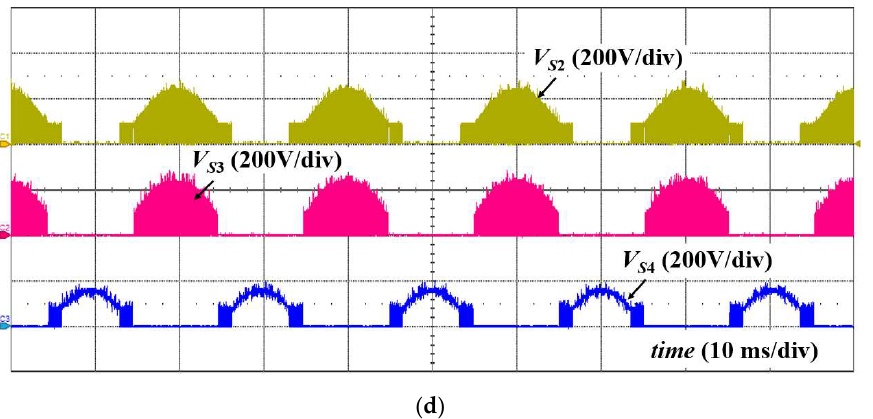
Figure 8. Experimental results with V in = 80 V. ( a ) Diode D 1 and switch S 1 voltage. ( b ) Switches S 2 , S 3 , S 4 voltage. ( c ) Capacitors C 1 , C 2 voltage, and inductor L 1 current. ( d ) inverter output voltage v ab , load voltage v o , and inductor L 2 current.